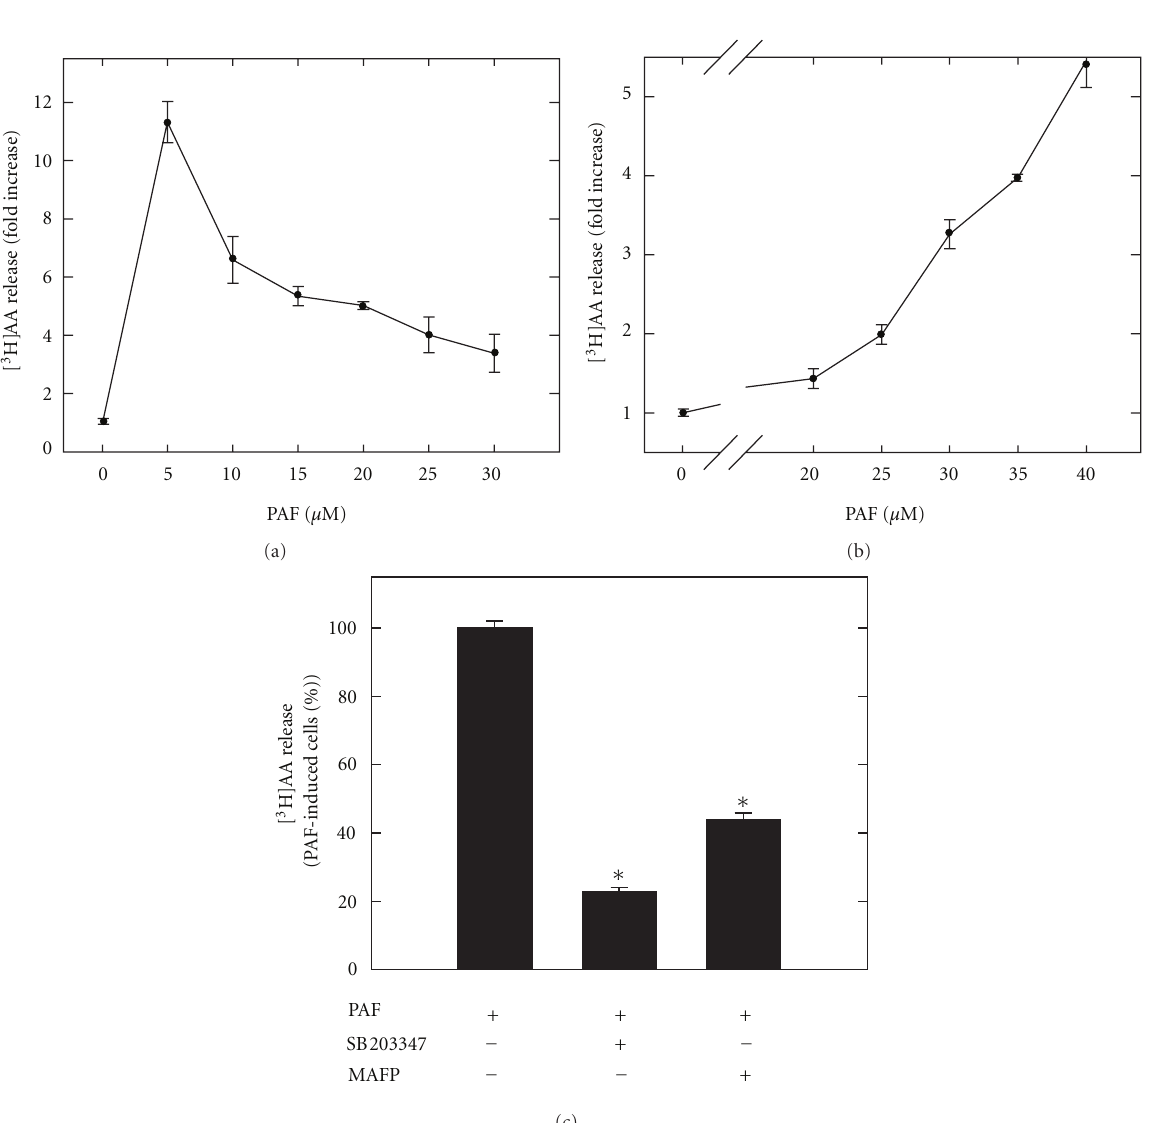
Figure 1: PAF and [ 3 H]AA release in human monocytes. Prelabeled THP-1 cells were stimulated with PAF, and [ 3 H]AA release was measured by liquid scintillation counting. (a) The time course of PAF- (35 μ M) mediated [ 3 H]AA. (b) PAF stimulation for 5min mediates [ 3 H]AA release in a dose-dependent matter. (c) Shows inhibition of PAF-induced [ 3 H]AA by the sPLA 2 inhibitor SB203347 (10 μ M) and the cPLA 2 inhibitor MAFP (10 μ M). The PAF concentration used is 35 μ M. Data are expressed as means ± SD of triplicate determinations within separate experiments. Asterisks indicate that values are statistically di ff erent from PAF-treated cells ( ∗